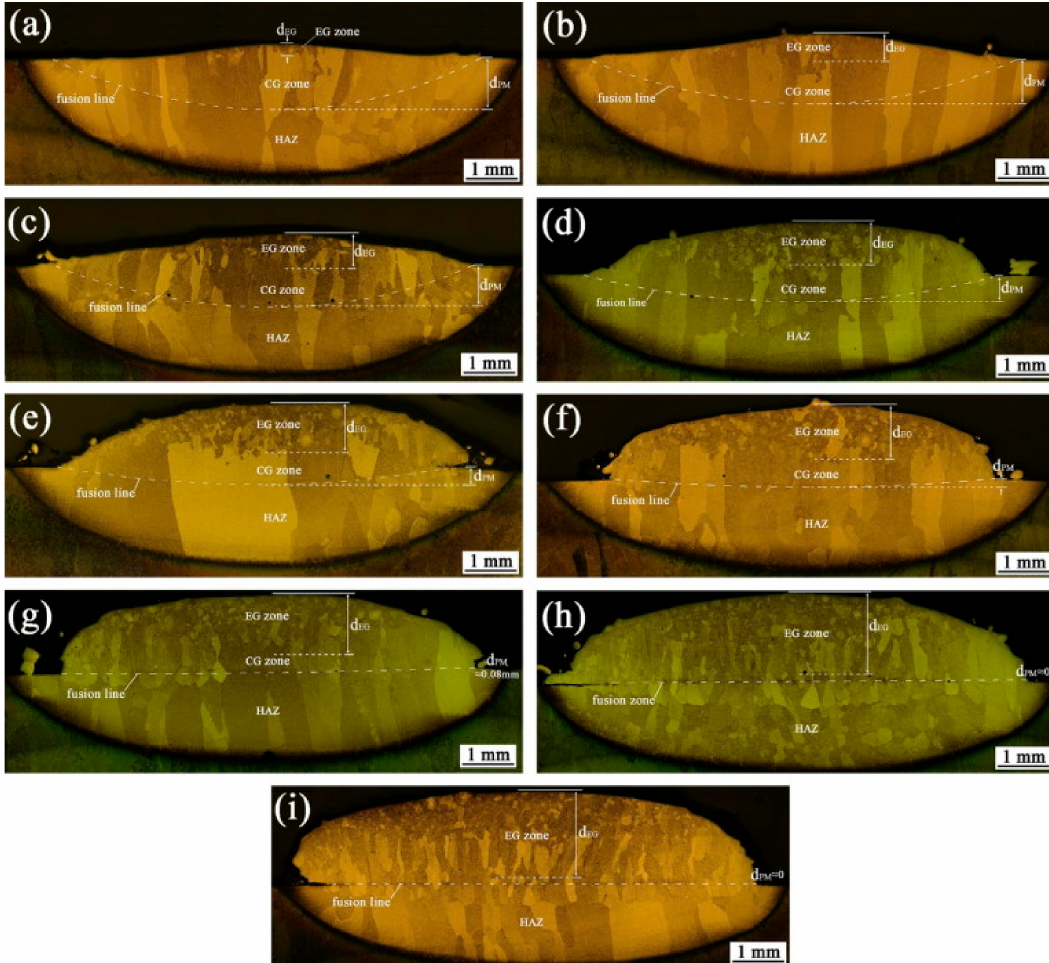
Figure 5. Optical micrographs showing the as-deposited prior beta grain morphologies on transverse cross section of single-track deposited specimens as a function of mass deposition rate, ( a ) 6 g/min, ( b ) 11 g/min, ( c ) 15 g/min, ( d ) 25 g/min, ( e ) 31 g/min, ( f ) 36 g/min, ( g ) 44 g/min, ( h ) 55 g/min and ( i ) 59 g/min (reproduced with permission from [87] Copyright Elsevier,